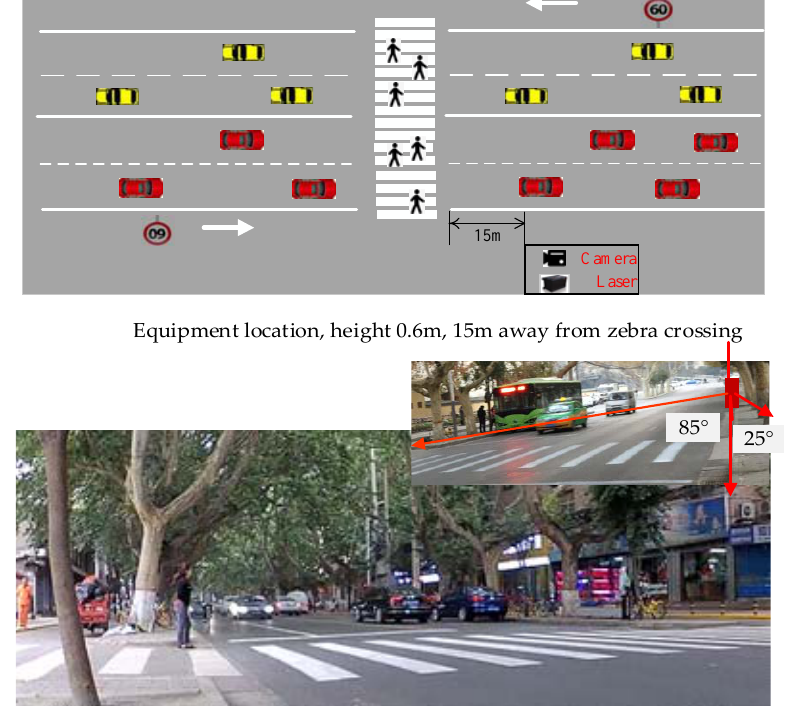
Figure 4. Parameter acquisition equipment.